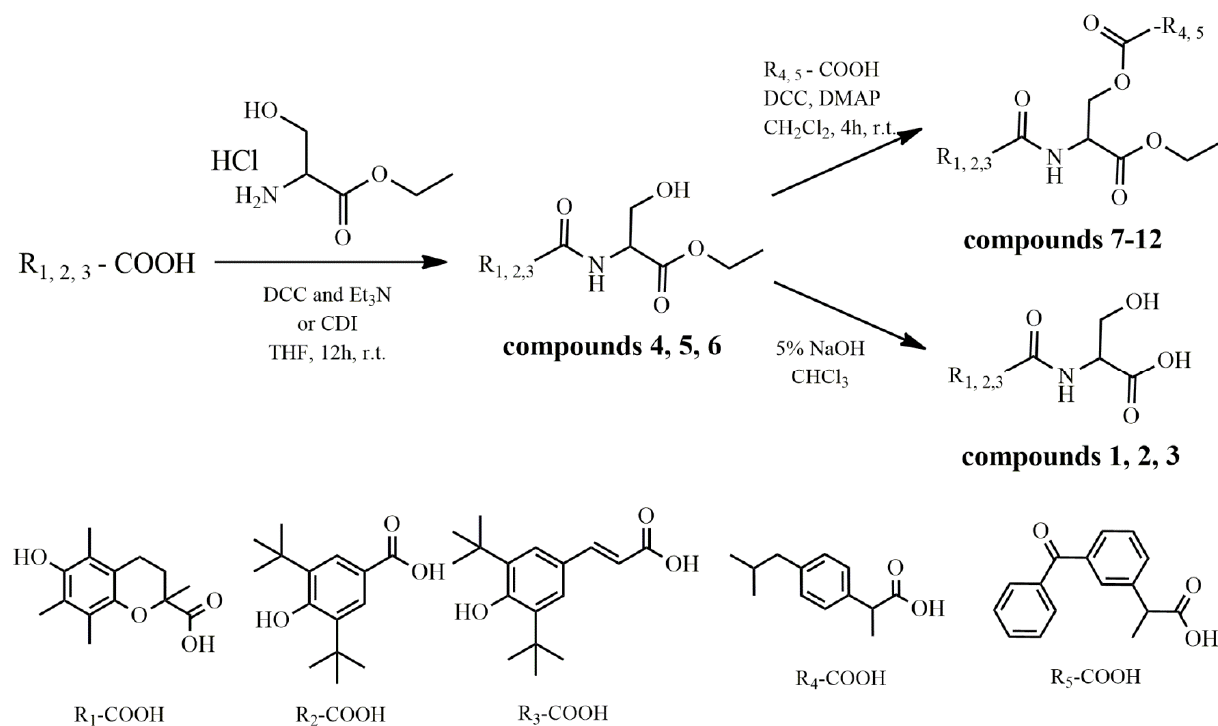
Figure 2. Synthesis of the compounds. DCC: N , N ′ -dicyclohexylcarbodiimide; CDI: carbonyldiimidazole; DMAP: N , N - dimethylaminopyridine; Et 3 N: triethylamine; THF: tetrahydrofuran; r.t: room temperature.